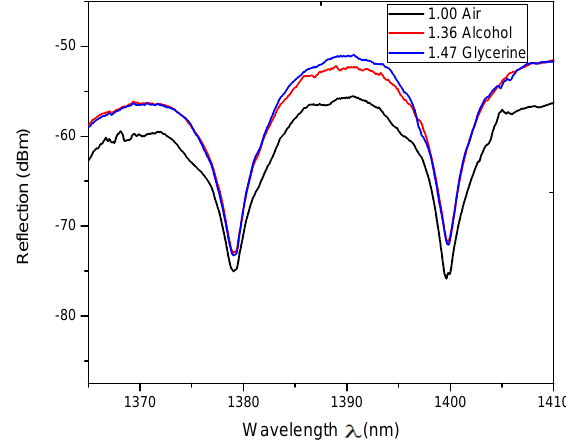
Figure 7. Measured reflection spectra of the IFPI immersed in different materials.